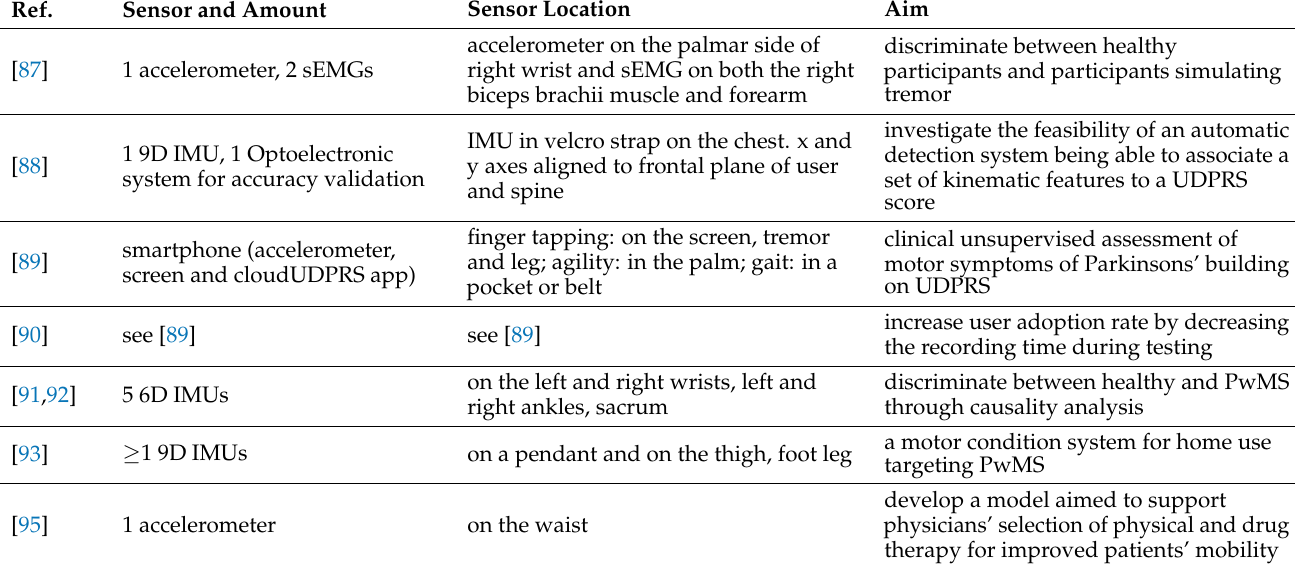
Table 10. Study characteristics for studies on neurological